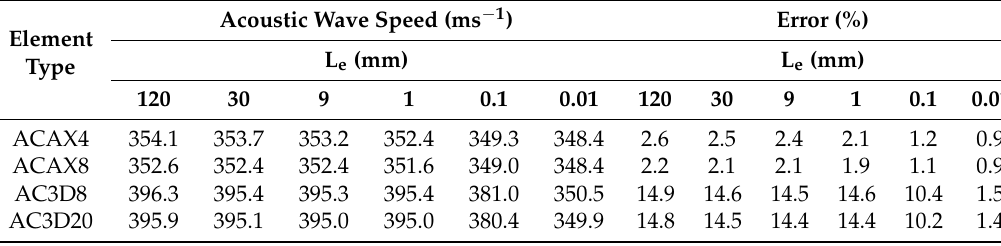
Table 4. Acoustic mesh sensitivity study showing the acoustic speed computation